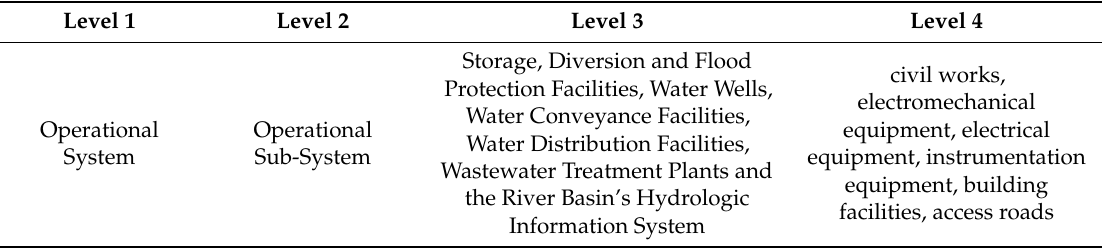
Table 1. Asset Inventory Hierarchy.